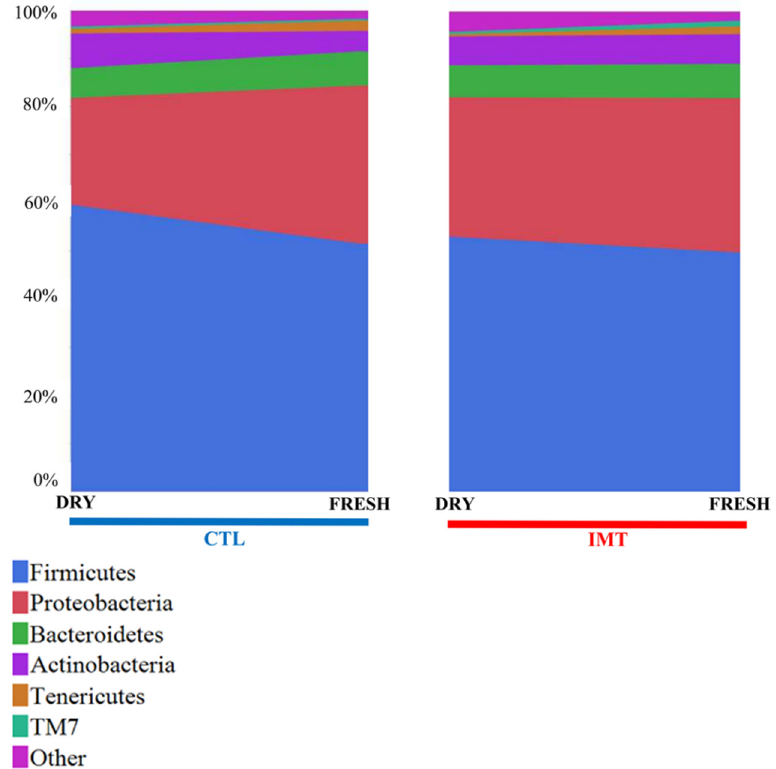
Figure 1. Mean percentage distribution for the top five most prevalent phyla for each sampling point by treatment group. IMT: treatment group representing cows receiving intramammary antimicrobial drug treatment at dry-off; DRY: samples collected at the time of dry-off; FRESH samples: samples collected from post-partum cows between 4 and 11 days in milk; CTL: control group representing cows not receiving intramammary antimicrobial drug treatment at dry-off.